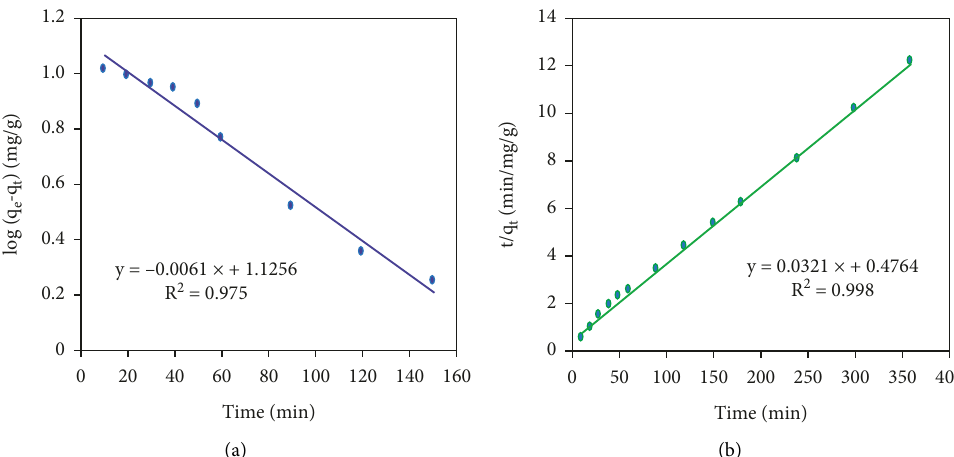
Figure 10: (a) Pseudo-1st-order, and (b) pseudo-second-order kinetic plots for the biosorption of Cr(VI) onto